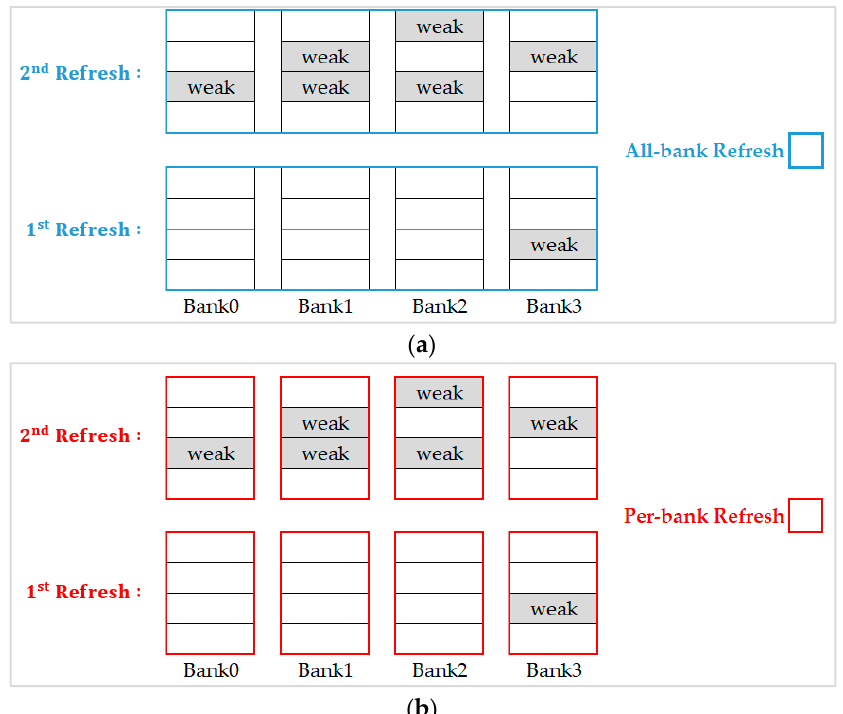
Figure 6. ( a ) All-bank refresh to refresh weak row; ( b ) per-bank refresh to refresh weak row.